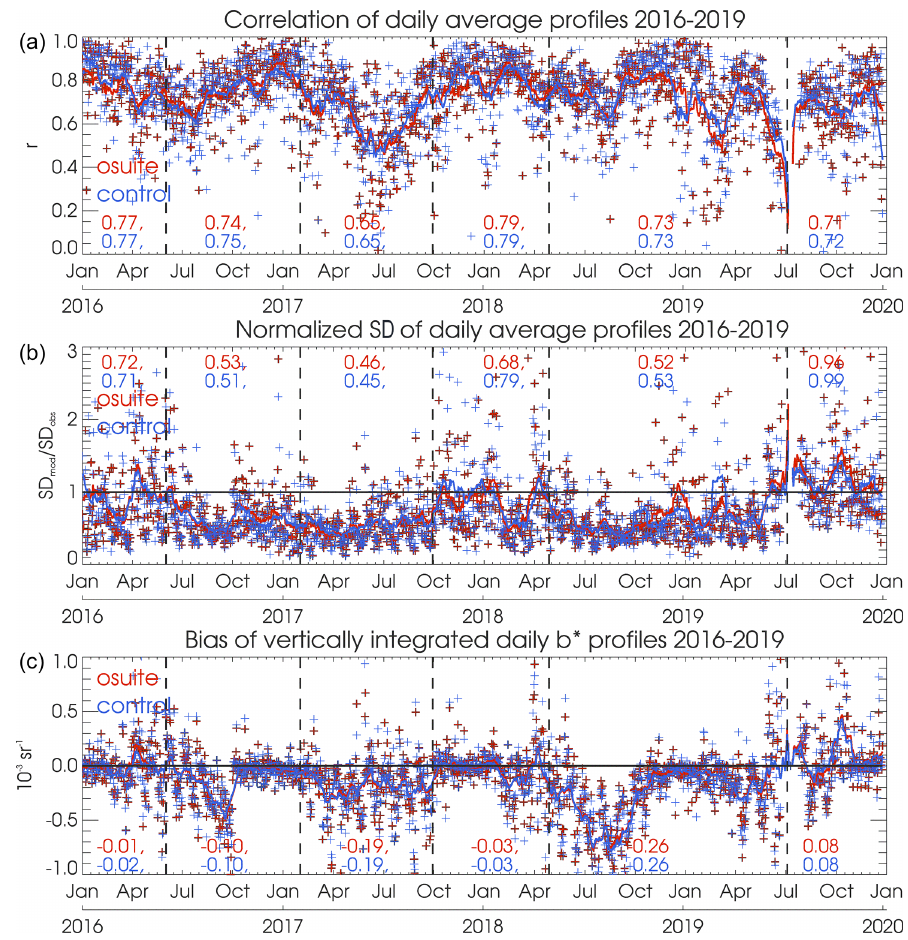
Figure 5. Pearson’s correlation coefficients ( r ; a ), standard deviation normalized towards ceilometer observations (b) and integrated bias of daily average β ∗ (z) profiles of IFS-AER versus ceilometers for 2016–2019. Red crosses denote ASM; blue crosses denote the control run. The 3d moving average line and median values over the periods with constant model configurations are